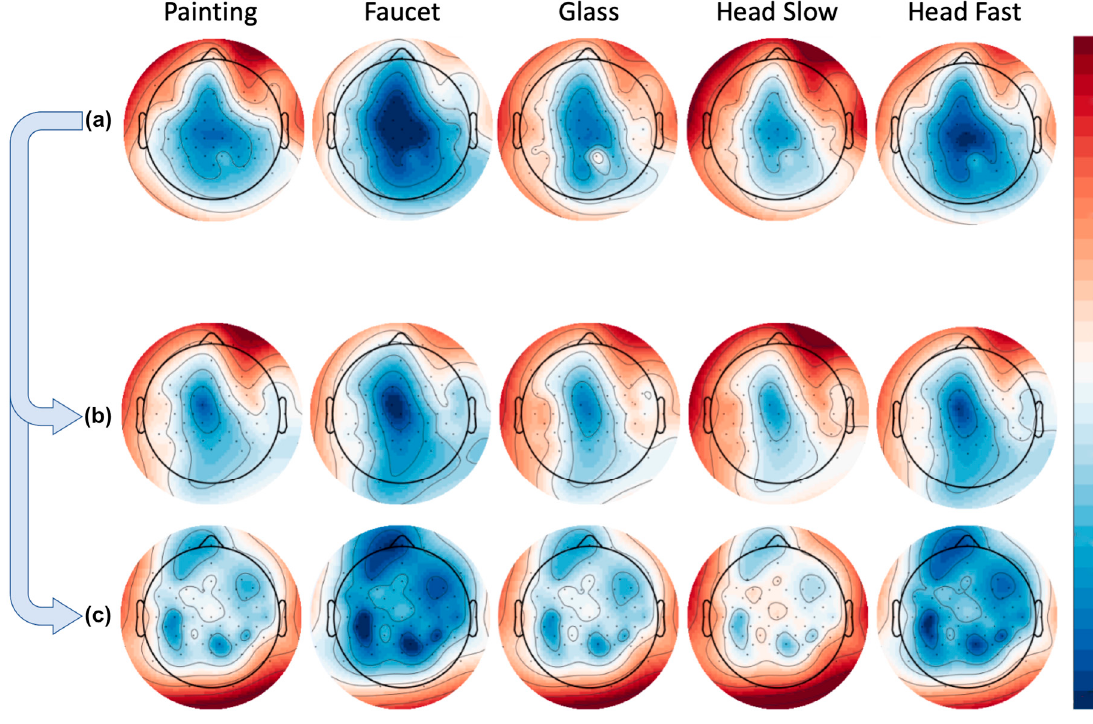
Figure 11. Group averaged bandpower per condition over high beta frequency. Rows represent tasks (painting, faucet, glass, head slow, head fast). ( a ) Using all available data. ( b ) Artifact-only condition. ( c ) Brain-only